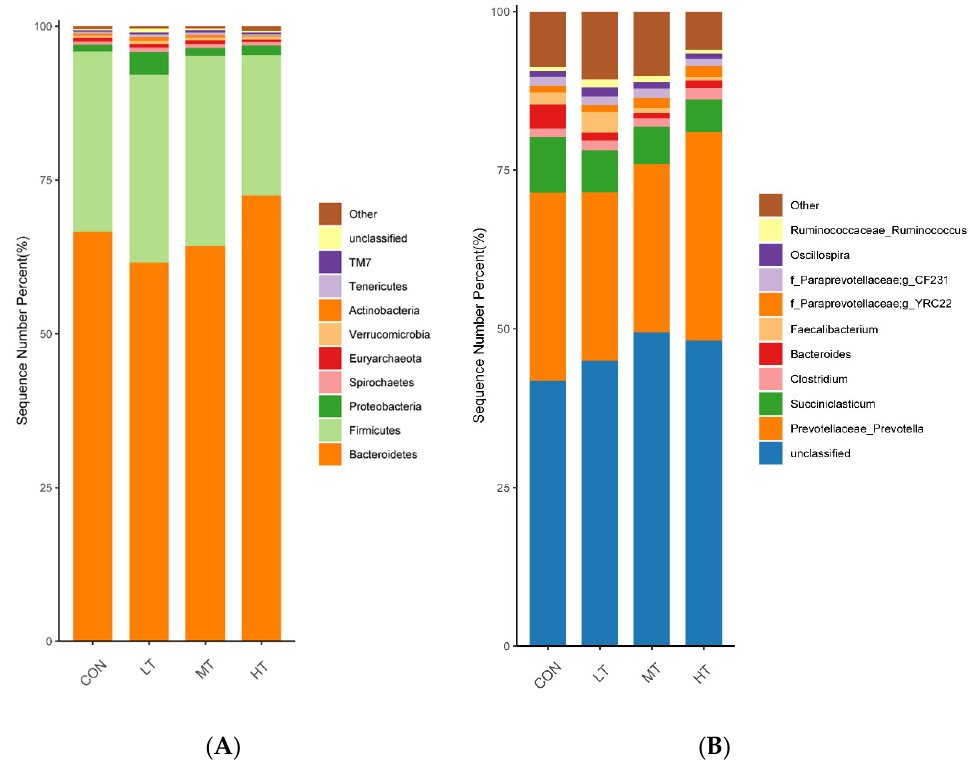
Figure 2. Distribution of bacterial taxa averaged under phyla ( A ) and genera ( B ) level across the different treatment groups (as a percentage of the total sequence). Table 5. Species and relative abundance of ruminal fluid bacteria in cattle at phylum level and genus level.